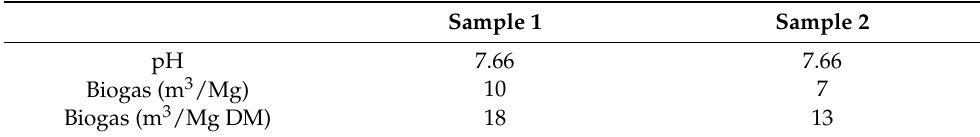
Table 2. Research results on mizdra biogas yield.